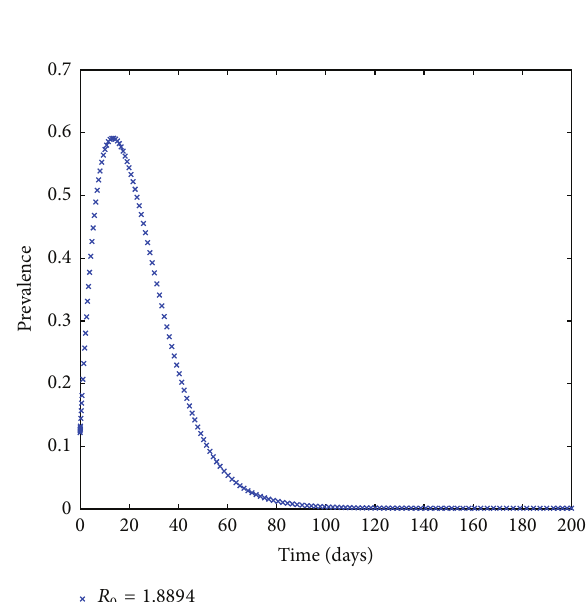
Figure 6: Exposed humans without any intervention strategies.